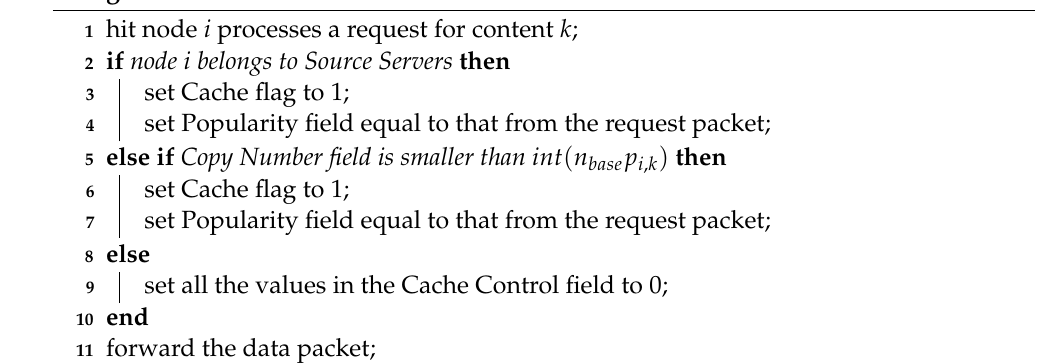
Algorithm 4: Data Packet Construction